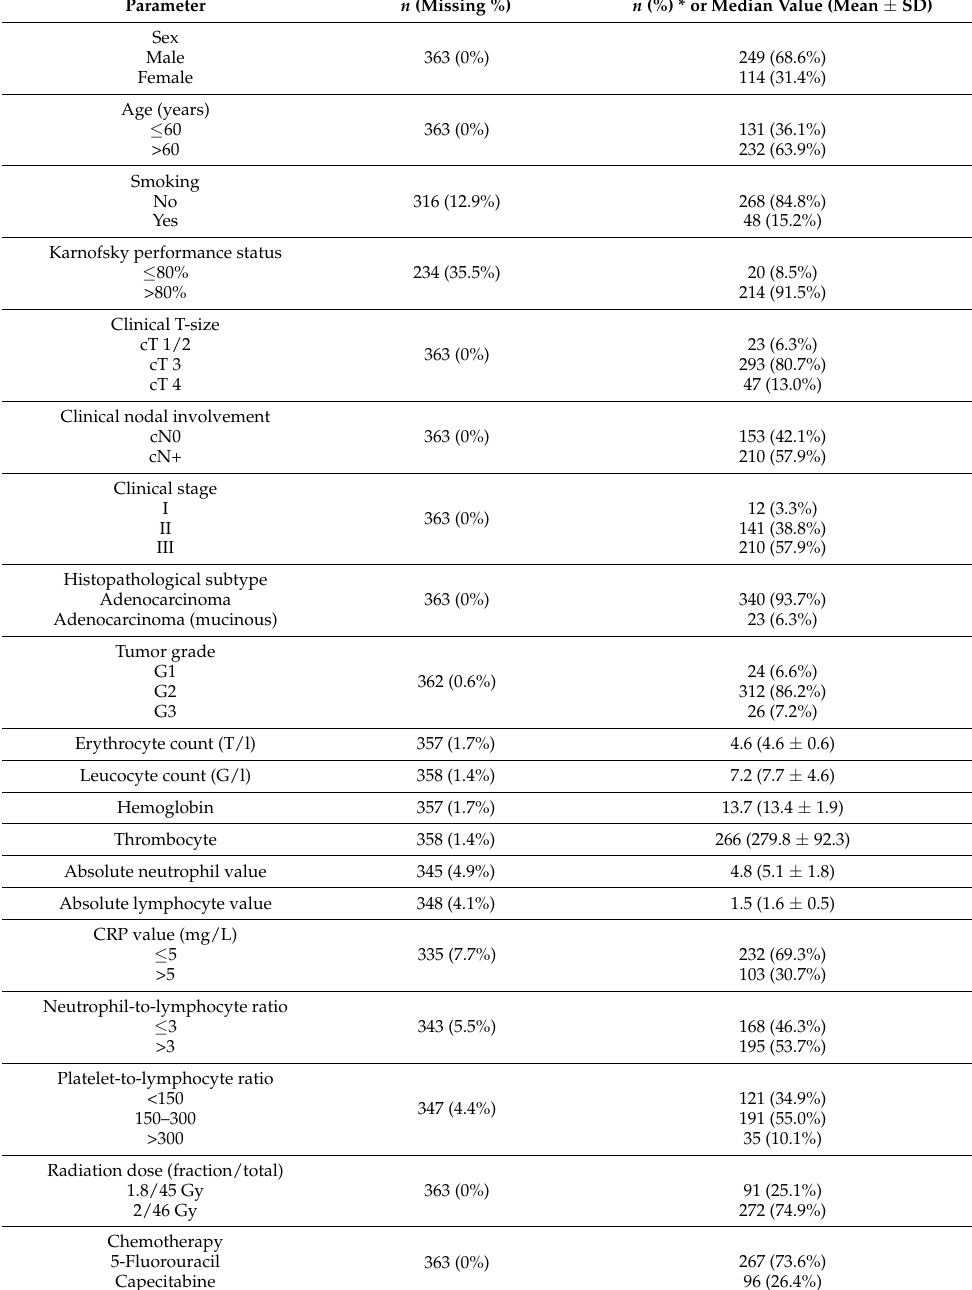
Table 1. Summary of baseline patient